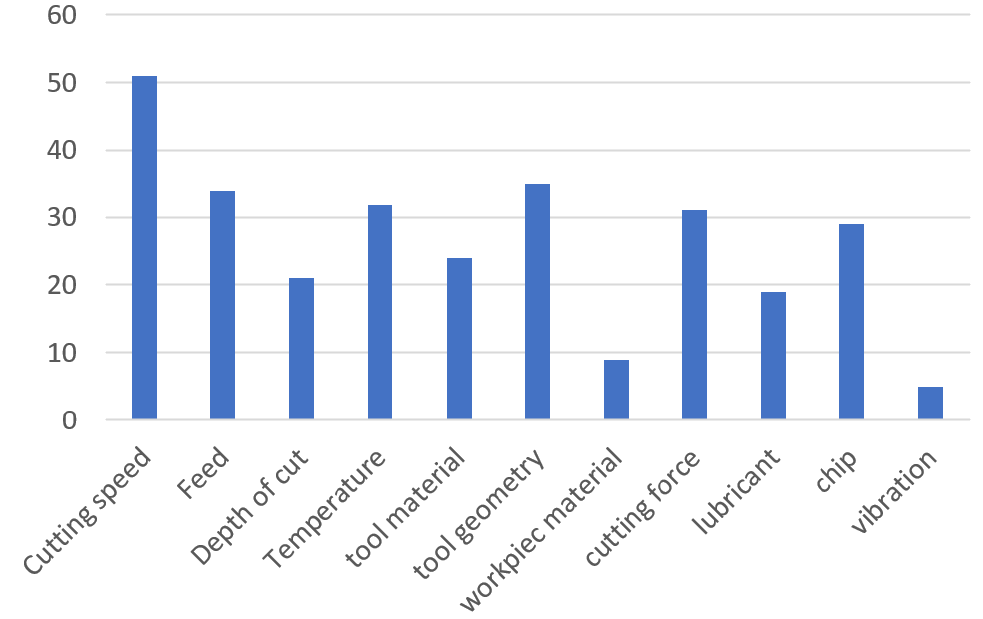
Figure 7. Number of references that studied important parameters affecting tool life in the database based on keywords (one paper may be in more than one category). based on keywords (one paper may be in more than one